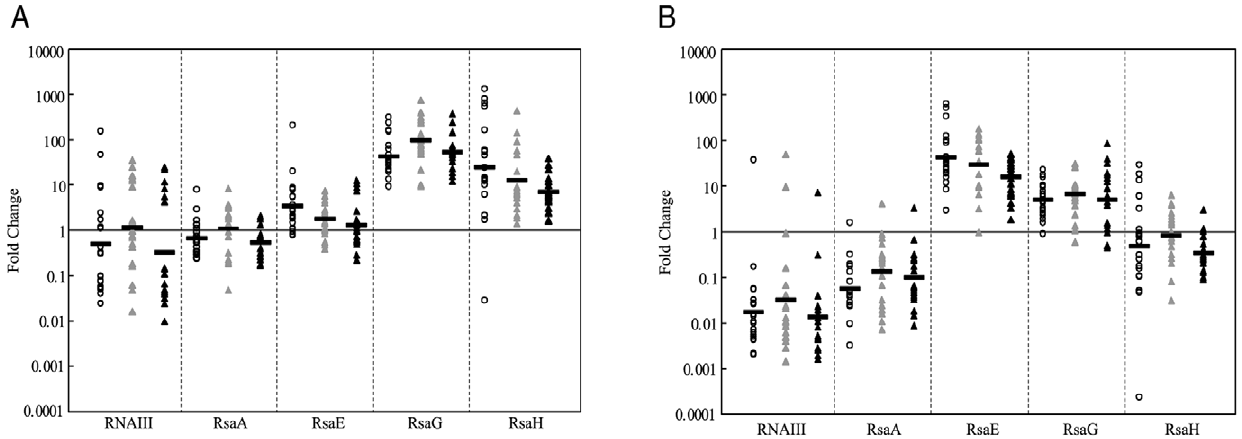
Figure 4. Comparison of sRNA expression in bacterial cultures and human samples. The results are expressed as the ratio of mRNA expression levels in vivo versus those in vitro . ( A ) Fold change in transcript levels for each sRNA in the human samples (circle: abscesses; grey triangle: cystic fibrosis sputa, black triangle: nasal) relative to the levels in bacteria at the mid-exponential growth phase in BH media. ( B ) Fold change in transcript levels for each sRNA in human samples relative to the levels in bacteria at the late-exponential phase in BH media. The bars indicate the geometric mean values.